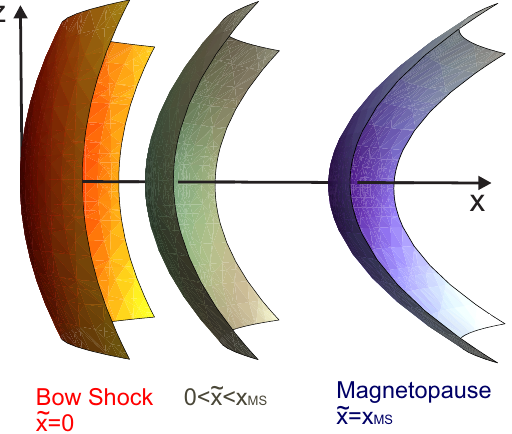
Fig. 4. Three-dimensional sketch of the elliptic paraboloids de- scribed by Eq. (19) for different ˜ x . The bow shock on the left side for ˜ x = 0 and the magnetopause on the right side for ˜ x = x MS